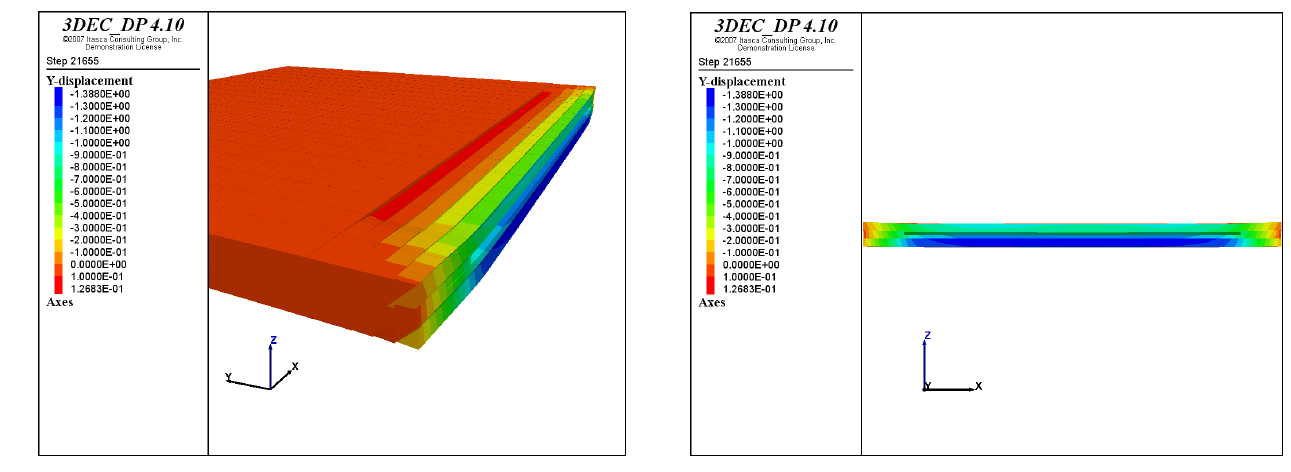
Figure 21. Y-displacement nephogram ( α sj = 135, d = 1.41 m).